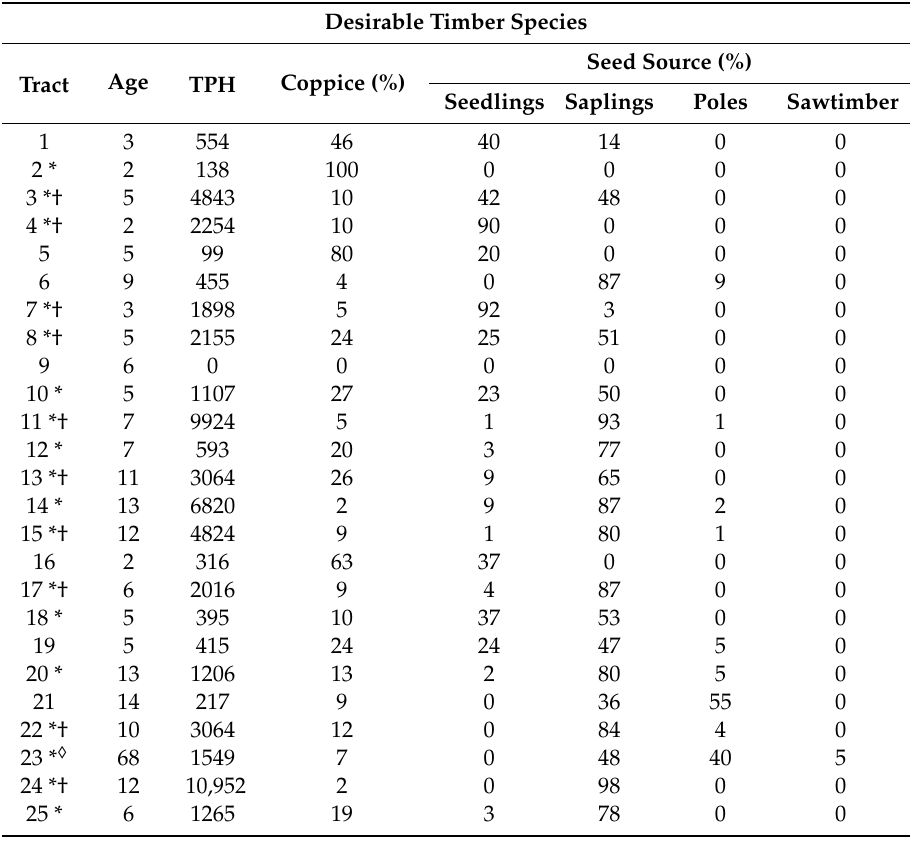
Table 4. Stand age, trees per hectare (TPH), and percent of TPH categorized as coppice and seed source for desirable timber species for each of the 25 tracts evaluated. This includes species listed in Table 2, Cypress ( Taxodium distichum ), and Tupelo ( Nyssa